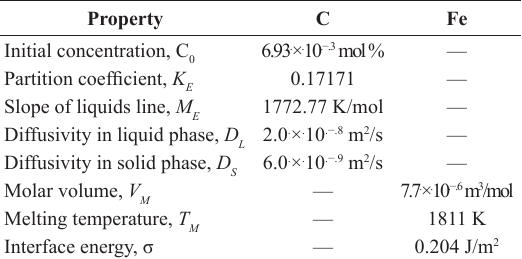
Table 3. Physical properties of the binary alloy analyzed. 4